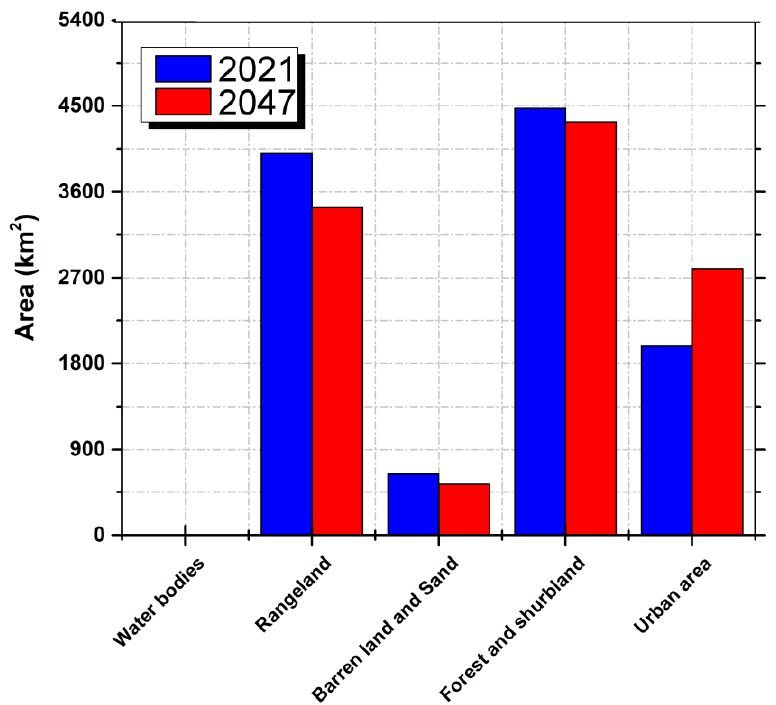
Figure 14. Area of Land use land cover change classes for the years 2021 and 2047.